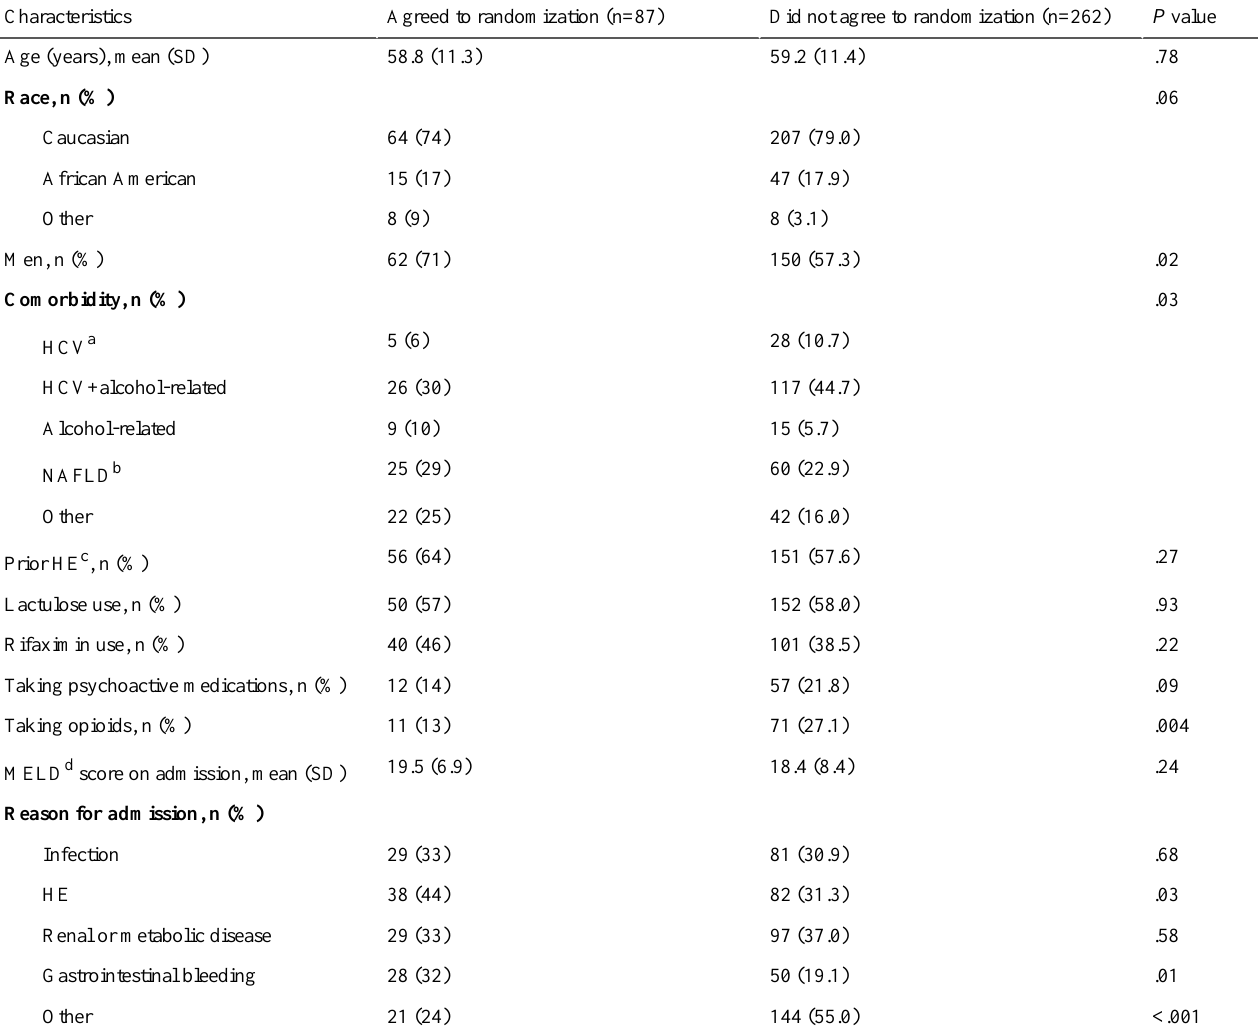
Table 1. Demographic and clinical characteristics of patients who agreed and did not agree to randomization for the health information technology intervention